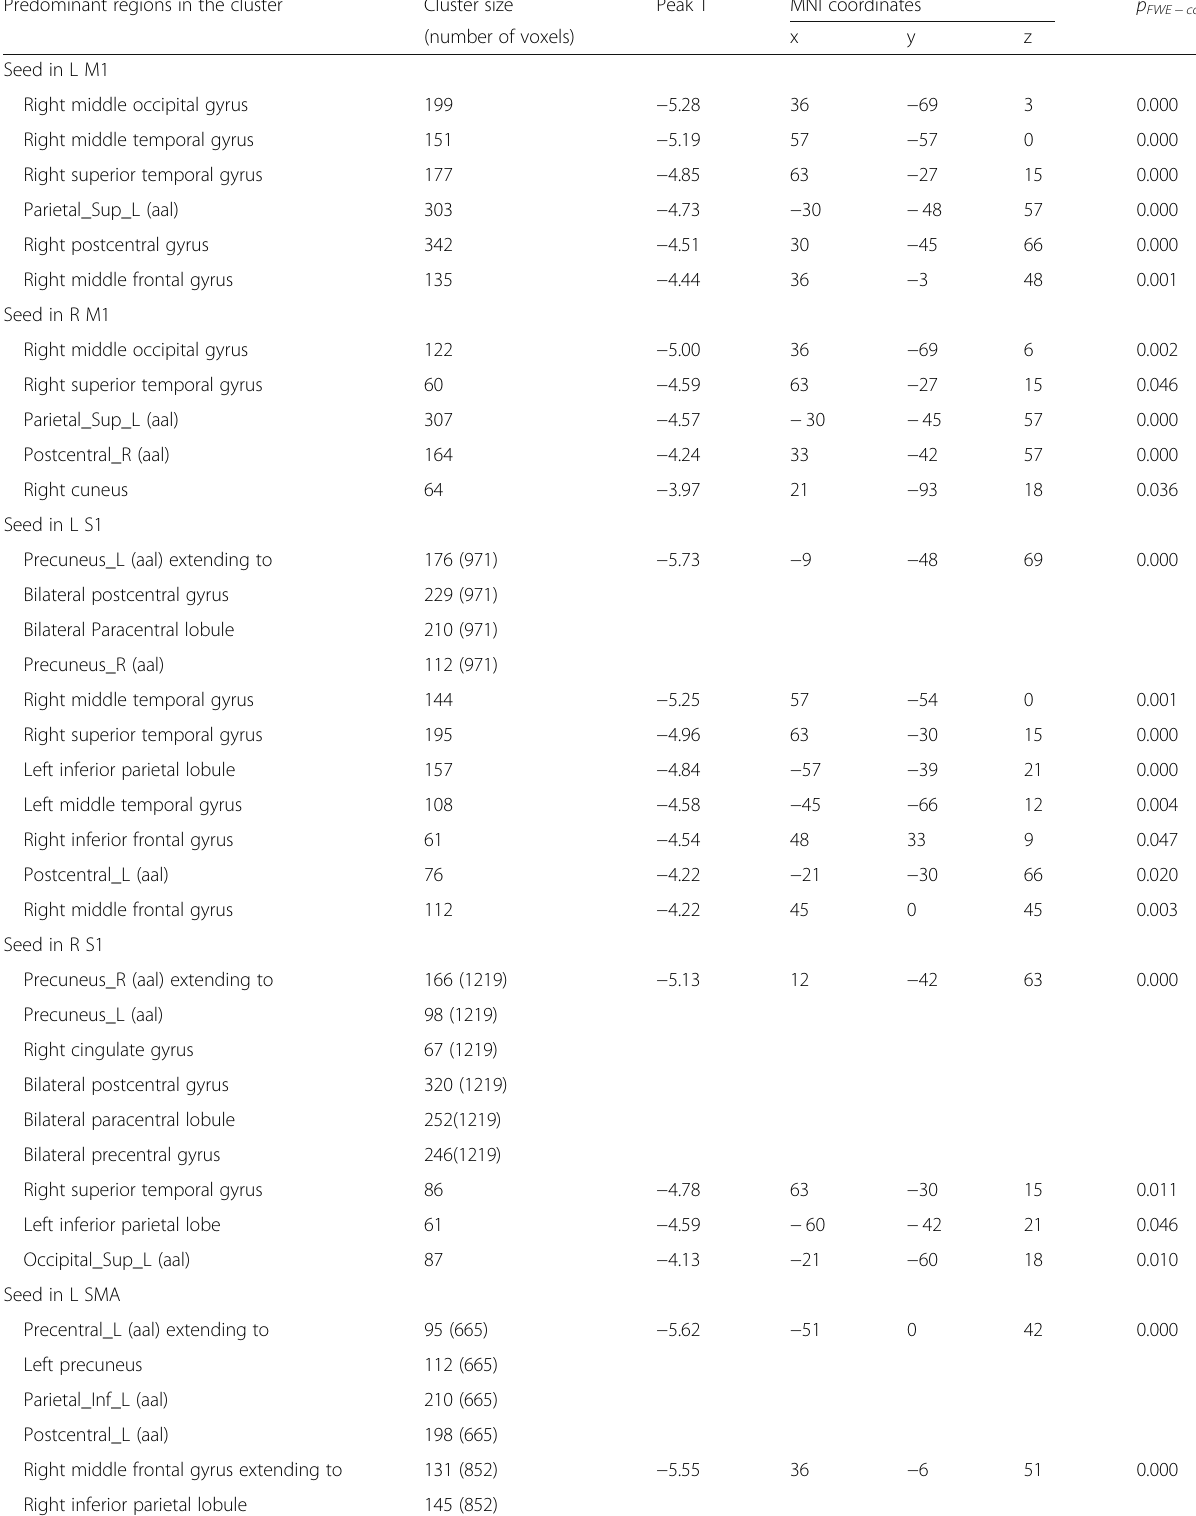
Table 2 Brain regions with decreased functional connectivity (FC) in migraine without aura (MWoA) compared to healthy controls (HC) Predominant regions in the